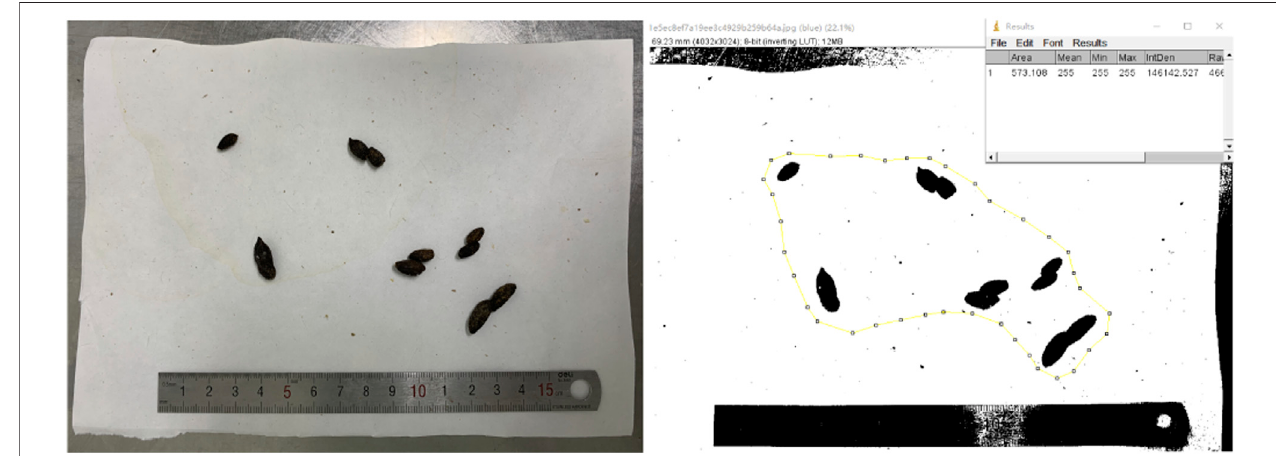
FIGURE 2 | Graph of the excrement before and after ImageJ